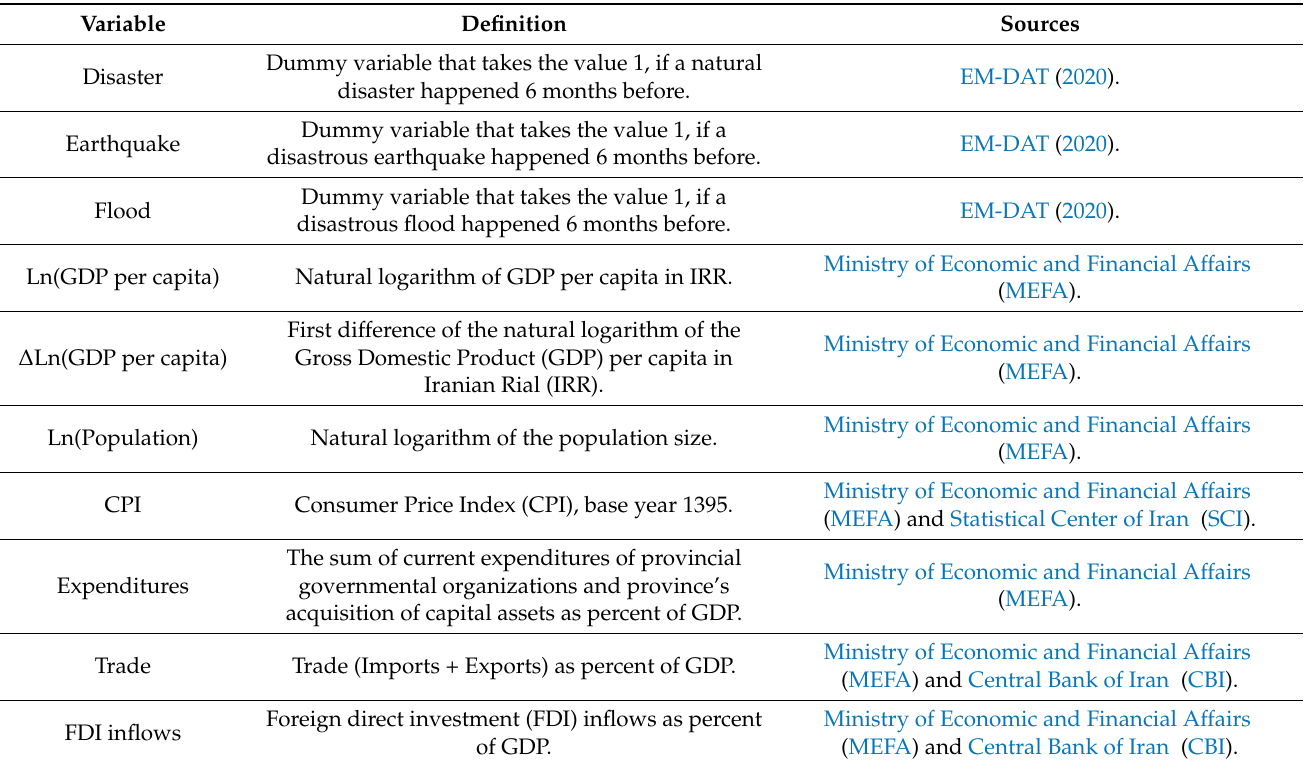
Table A1. Description and data sources of used variables.